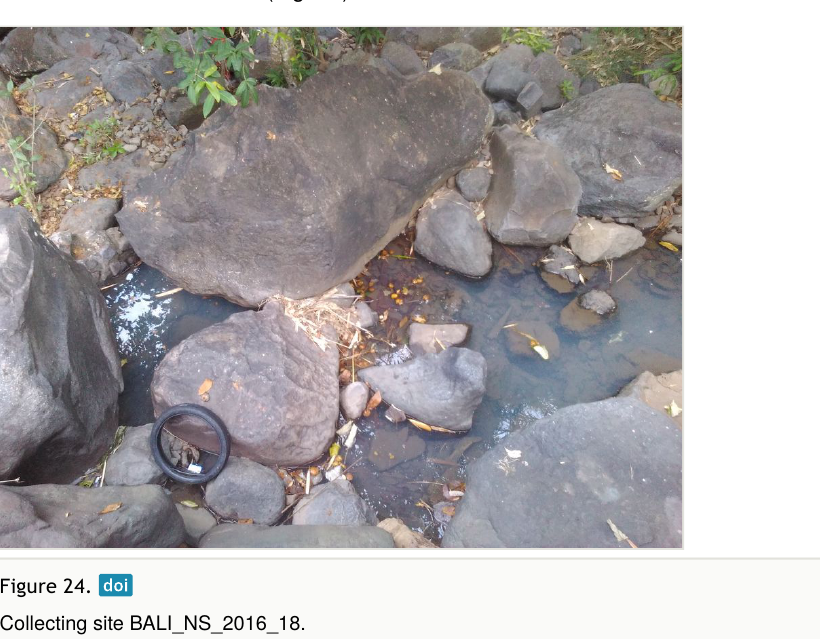
Geographic range outside Bali: Philippines, SE Asia. First record for Bali. Ecology The species occupies stagnant water habitats. In Bali, it was collected in rest pools in a streambed on volcanic rock (Fig. 24).